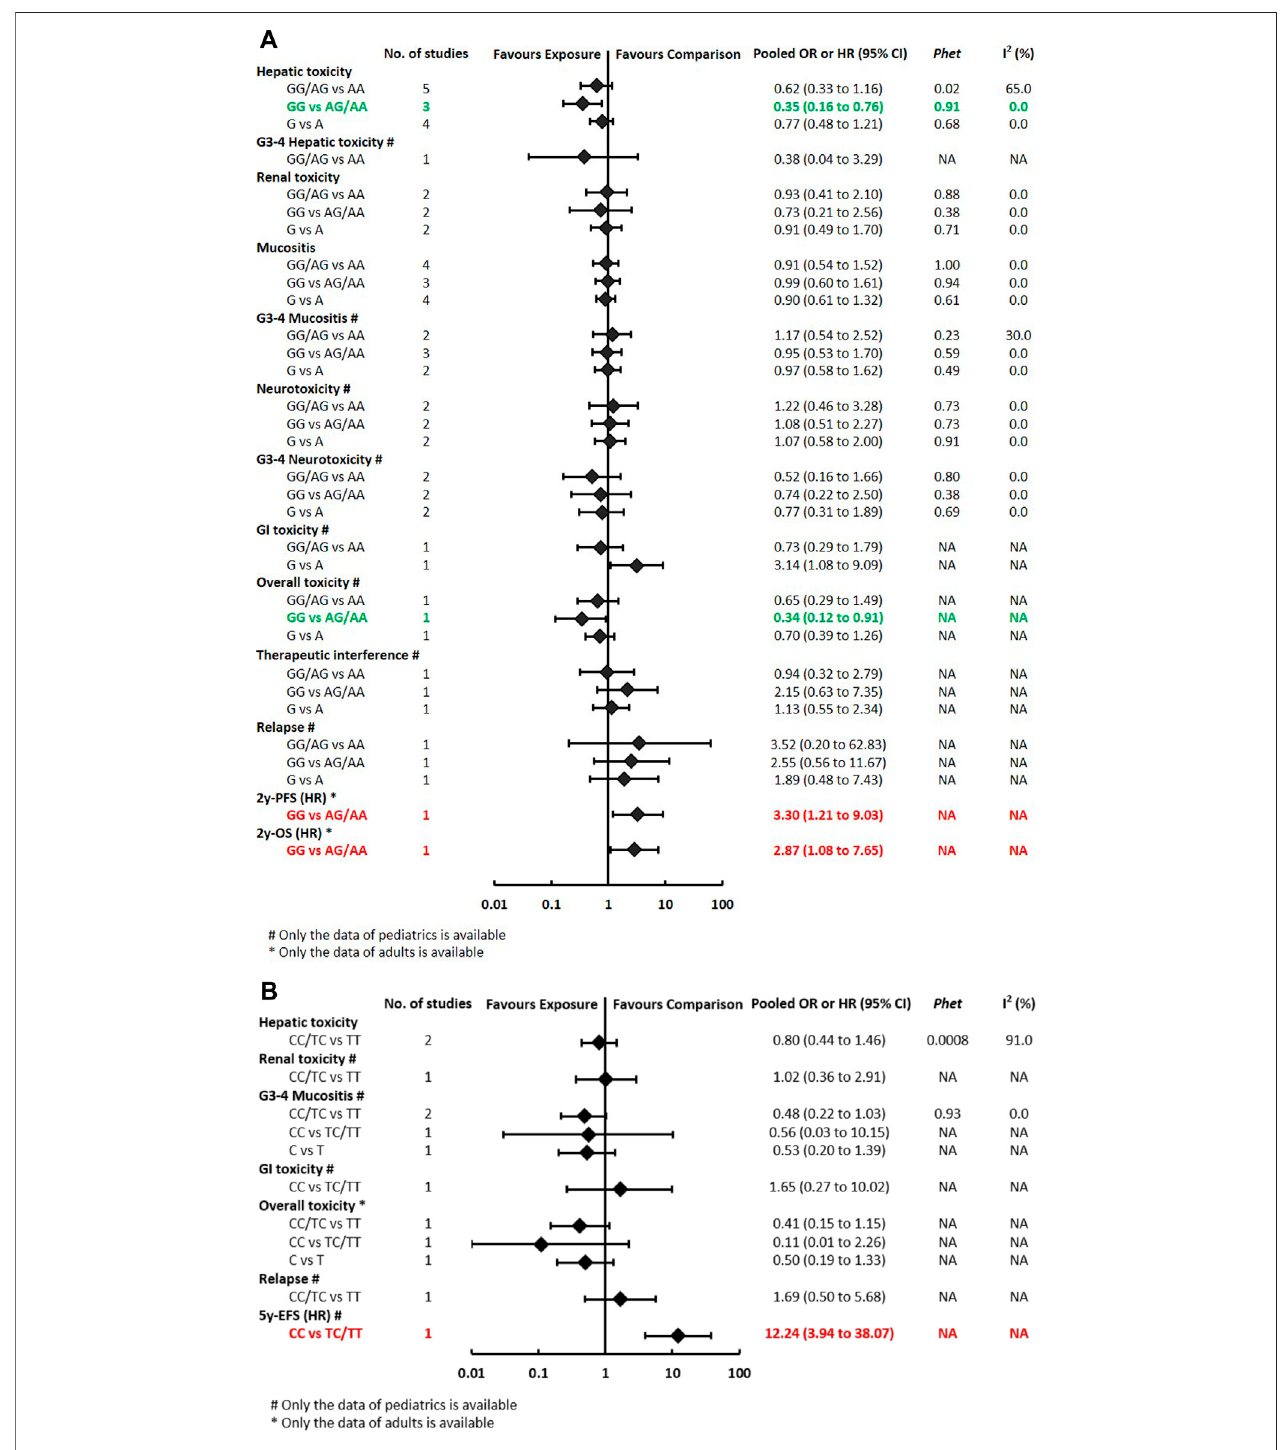
FIGURE 3A-B | (A) Findings of the association between RFC1 (rs1051266) and HDMTX-related outcomes under three genetic models. (B) Findings of the association between SLCO1B1 (rs4149056) and HDMTX-related outcomes under three genetic models.